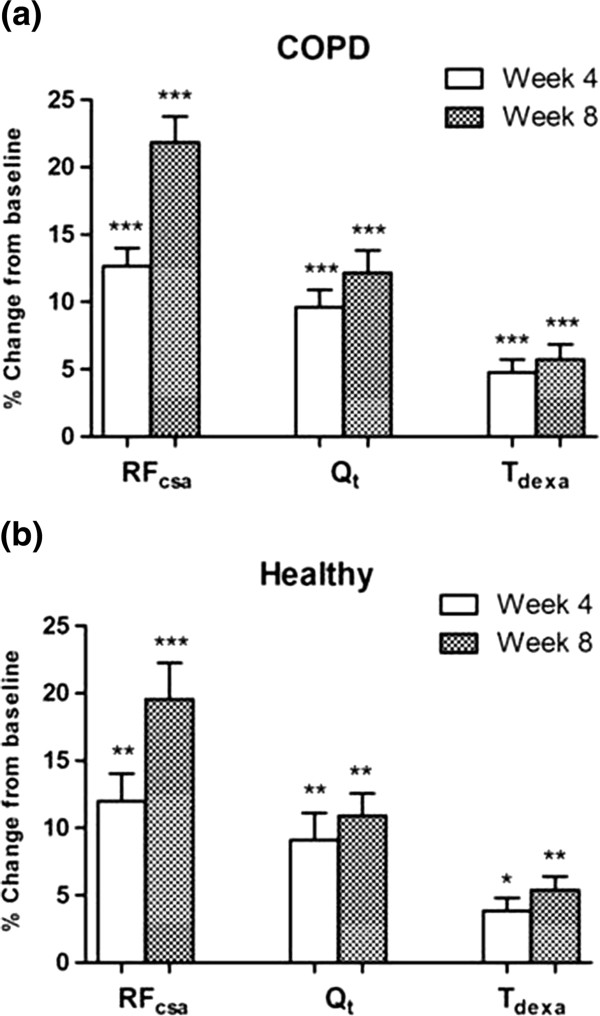
Percentage change from baseline in ultrasound and DEXA measured indices of quadriceps mass in (a) COPD, and (b) Healthy. Data presented as Means (SEM) RFcsa: Rectus femoris cross-sectional area measured by ultrasound, Qt: Quadriceps muscle thickness measured by ultrasound, Tdexa: Thigh lean mass measured by DEXA, Wilcoxon Signed rank test: *** p ≤ 0.0001; ** p < 0.001; * p < 0.01, significantly different from baseline.